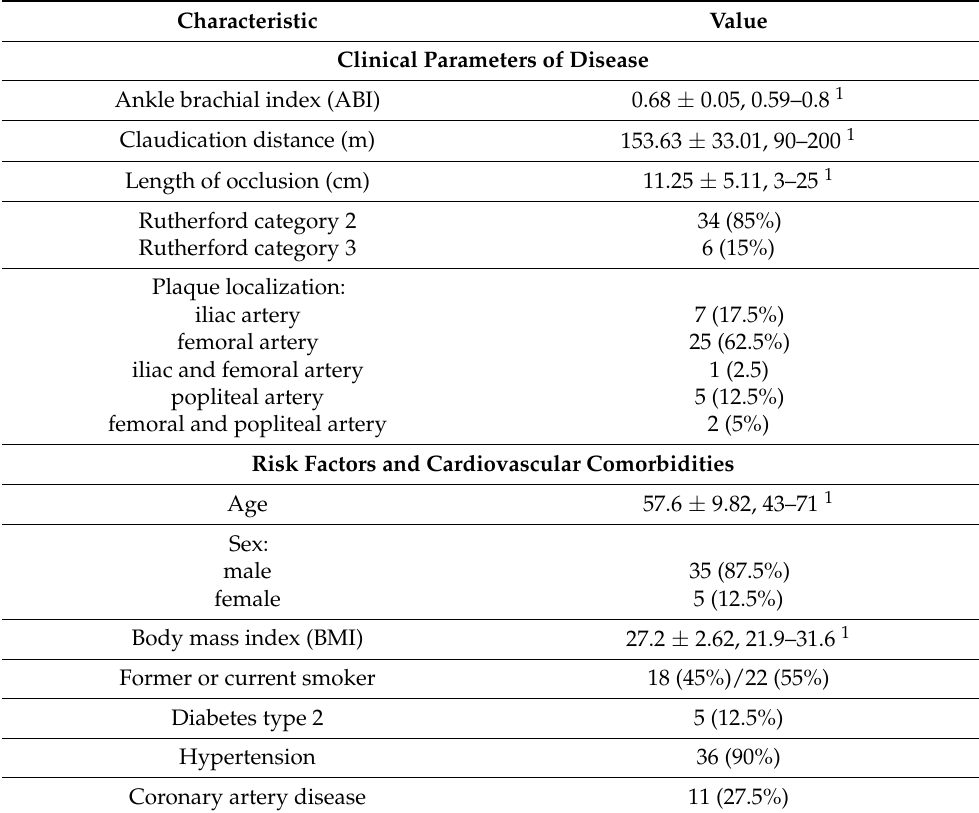
Table 1. Characteristics of 40 LEAD patients included in the study group. The table presents extended data provided in the previous study